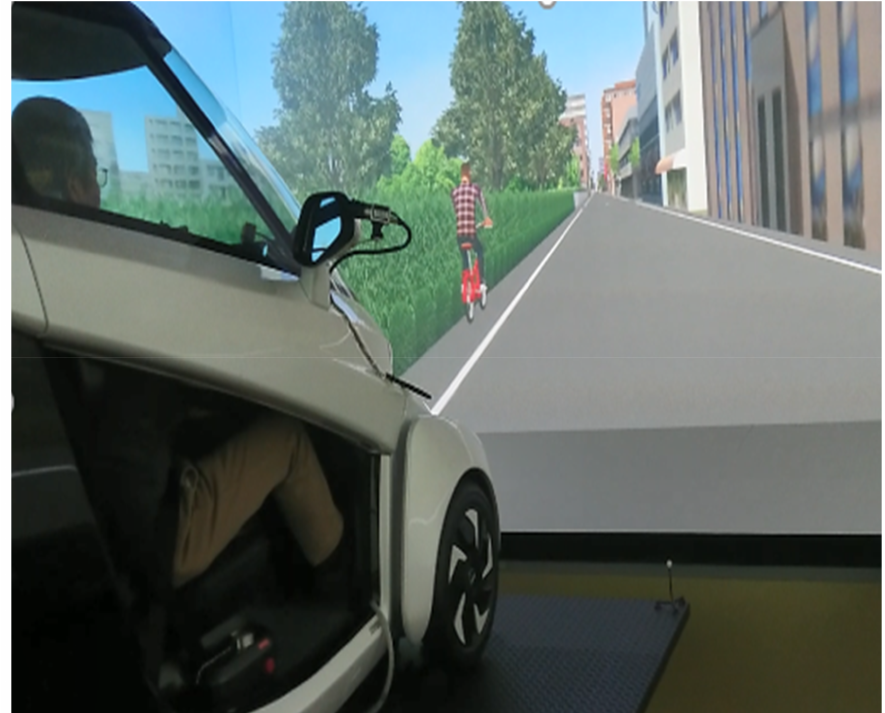
Figure 3. An example of the scene before the VRU’s overtaking